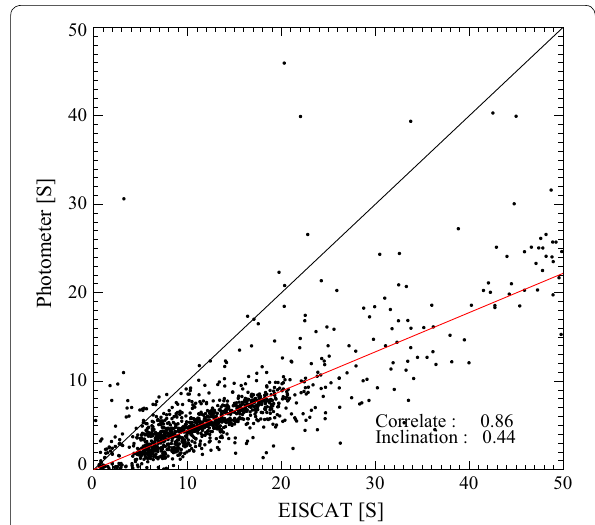
Fig. 6 Scattering plot of height-integrated Hall conductivity; the same as Fig. 4 except for the height-integrated Hall